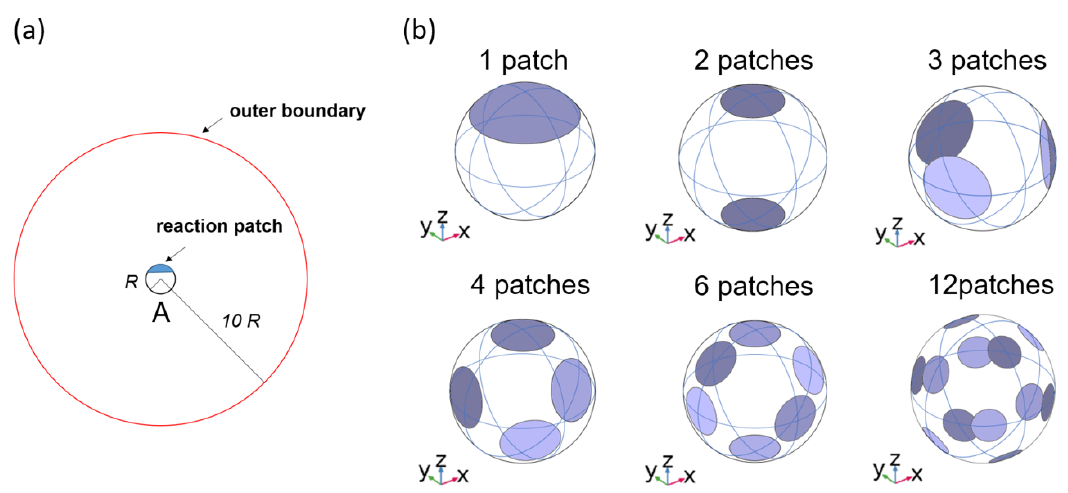
Figure 1. ( a ) Schematic diagram of our chemical reaction model. One reactant molecule A of radius R with a single reactive patch (blue) is located at the center of the coordinate system. An outer boundary condition (red) is located 10 R from the center. ( b ) Equidistant arrangements of N reactive patches on reactant A, with N = 2, 3, 4, 6, and 12, along with a single patch ( N = 1), under a fixed fraction of total reactive area over the entire surface area ( σ ) of 0.2. The bluish spherical caps represent the reactive patches. The figures in ( b ) were prepared by using COMSOL.